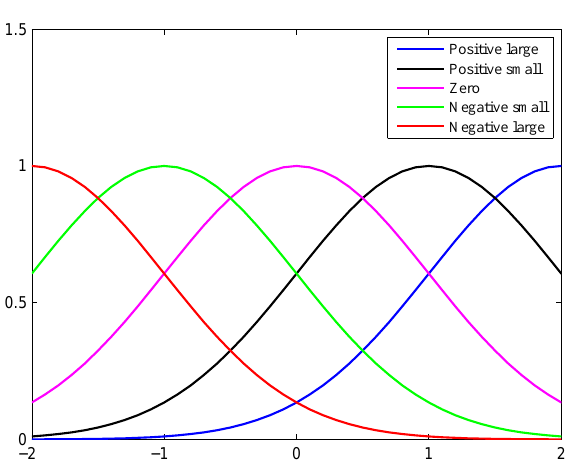
Figure 3. The membership